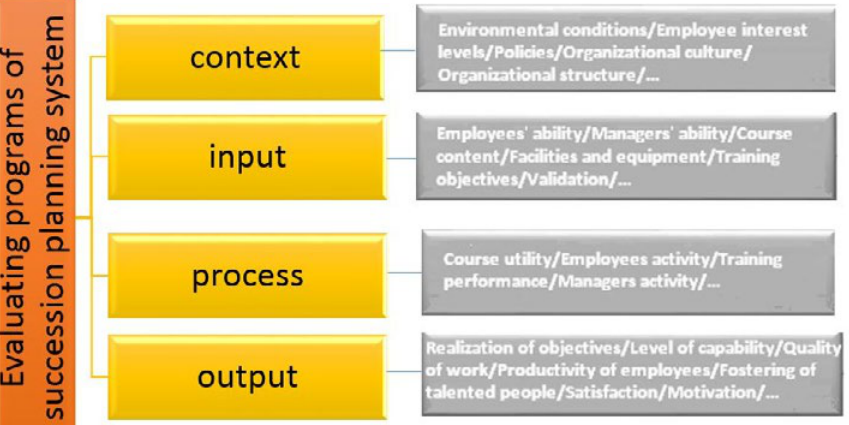
Fig. 1 : General model of the CIPP pattern (Stufflebeam and Zhang, 2017 Fig. 1: General model of the CIPP pattern (Stufflebeam and Zhang, 2017)